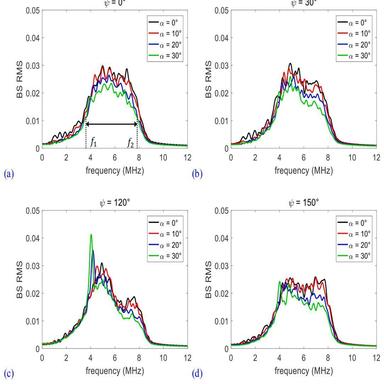
Experimentally measured BS RMS spectra versus rotation angle ψ. (a) ψ = 0 ◦ , (b) ψ = 30◦ , (c) ψ = 120◦ , and (d) ψ = 150◦ .